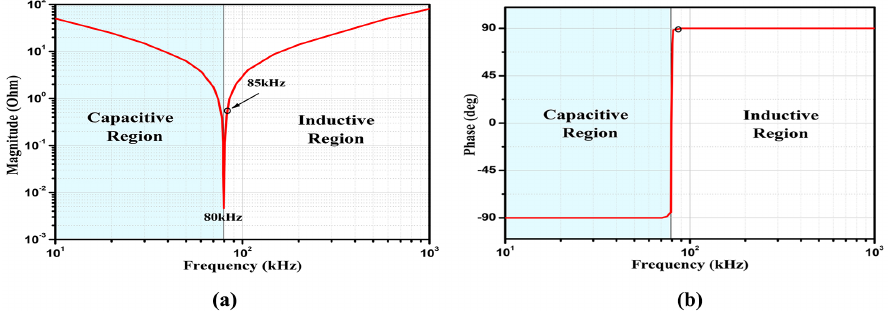
Figure 15. Resonant reactive shield impedance; ( a ) impedance magnitude; and ( b ) impedance phase.